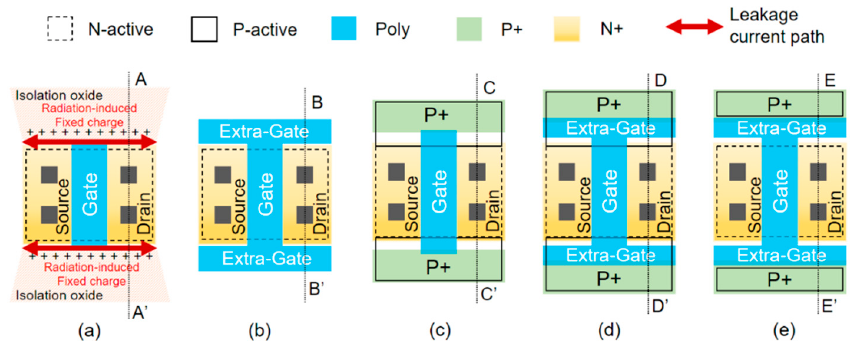
Figure 2. Radiation-tolerant pattern-specific n-MOSFET layout structures: ( a ) the standard structure; ( b ) the extended gate poly structure; ( c ) the structure to which the p-active and p+ doping regions are added; ( d ) the combined structure of ( b , c ); and ( e ) the same structure as ( d ) except that the n-active region is not overlapped with the p-active region.